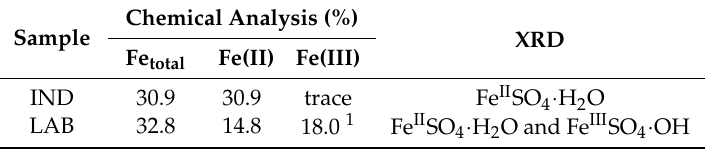
Table 1. Results of chemical and XRD analysis of two iron sulfate